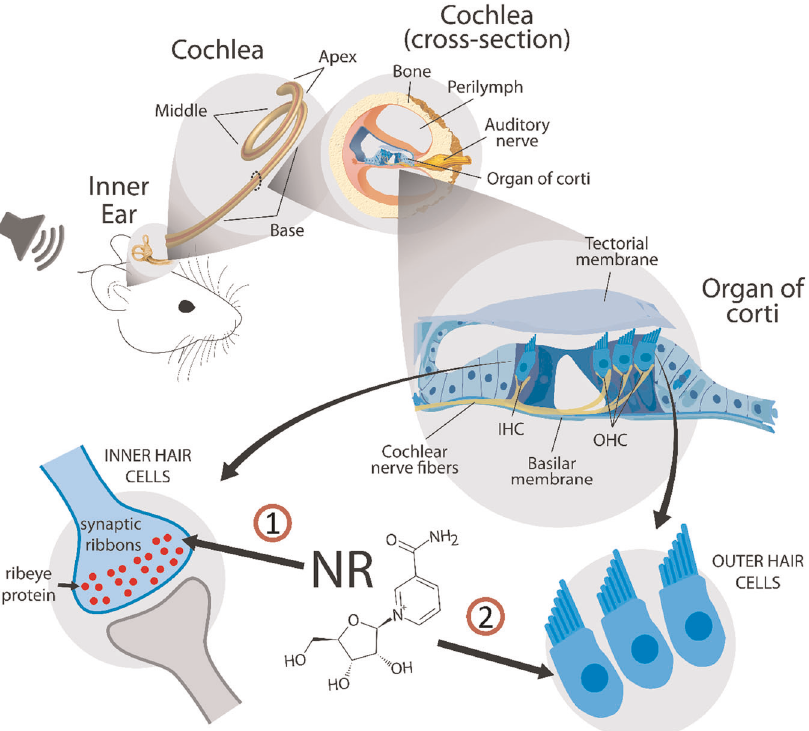
Fig. 7 Figure demonstrating that NR intervention enhances synaptic ribbon formation in inner hair cells of CSA − / − and CSB m/m mice (arrow #1), and prevents outer hair cell loss in CSB m/m mice (arrow #2). OHC stands for outer hair cells. IHC stands for inner hair